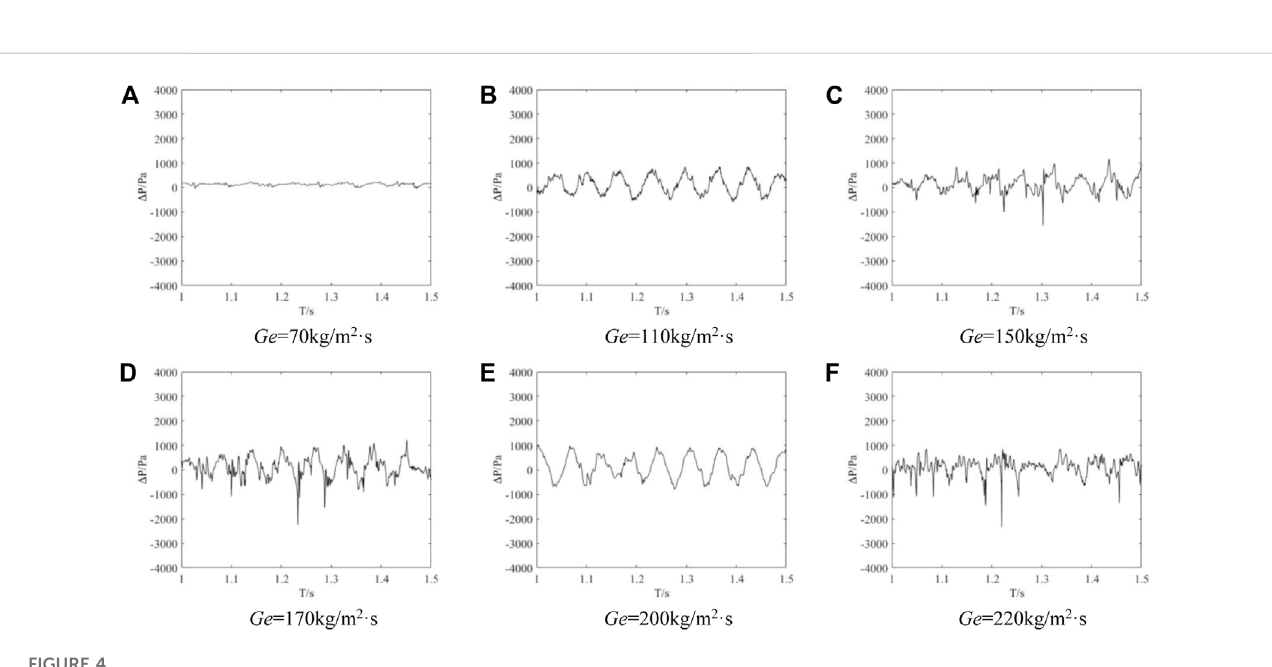
Noise time-domain signal at Δ T = 3 °